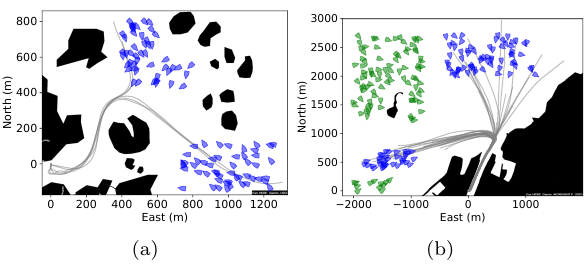
Figure 3: The sampled starting points for evaluation: (a) Mausund, and (b) Trondheim. Note that blue is within human experience, while green is beyond human